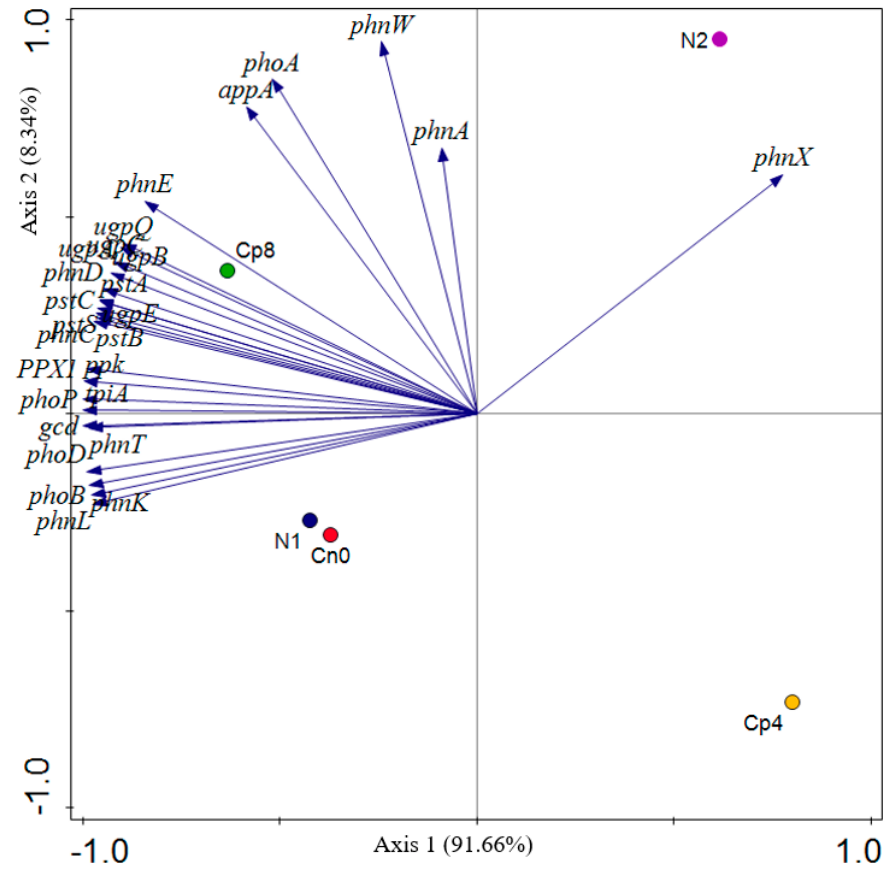
Figure 5. Principal component analysis of the phosphorus cycling genes under fertilization and control treatments within the rhizosphere of maize plants. Cp8 (8 tons/ha compost), Cp4 (4 tons/ha compost manure), N2 (120 kg/ha NPK), N1 (60 kg/ha NPK), and Cn0